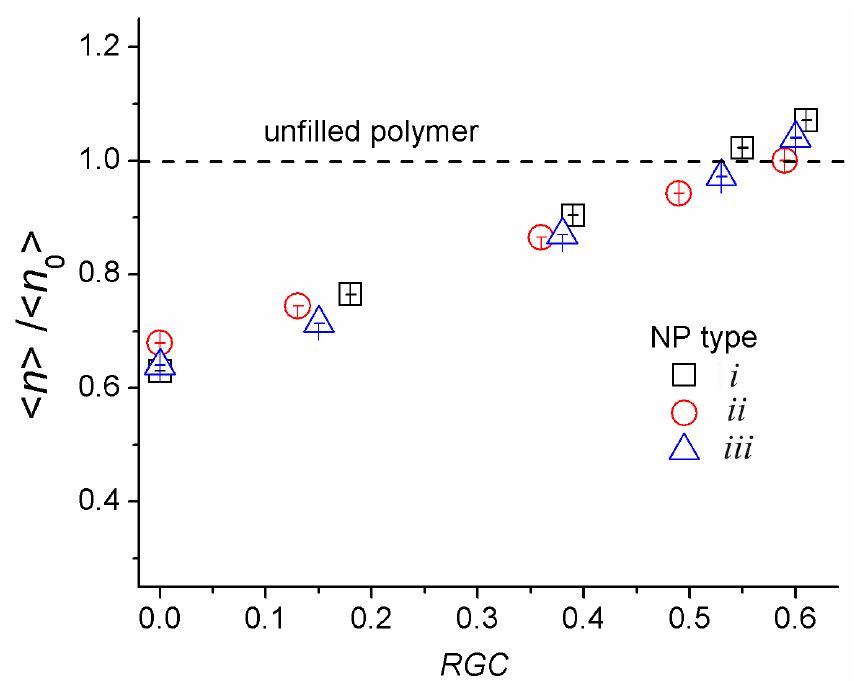
Figure 4. Normalized averaged density of load-bearing chains < n >/< n 0 >. Here < n > is average n α ( α = x , y , z ) for the nanocomposites with nanoparticles of i , ii , and iii types. Reference value < n 0 > = 1.67 ± 0.03 is the averaged n α for the unfilled network. The dashed line corresponds to the unfilled polymer.